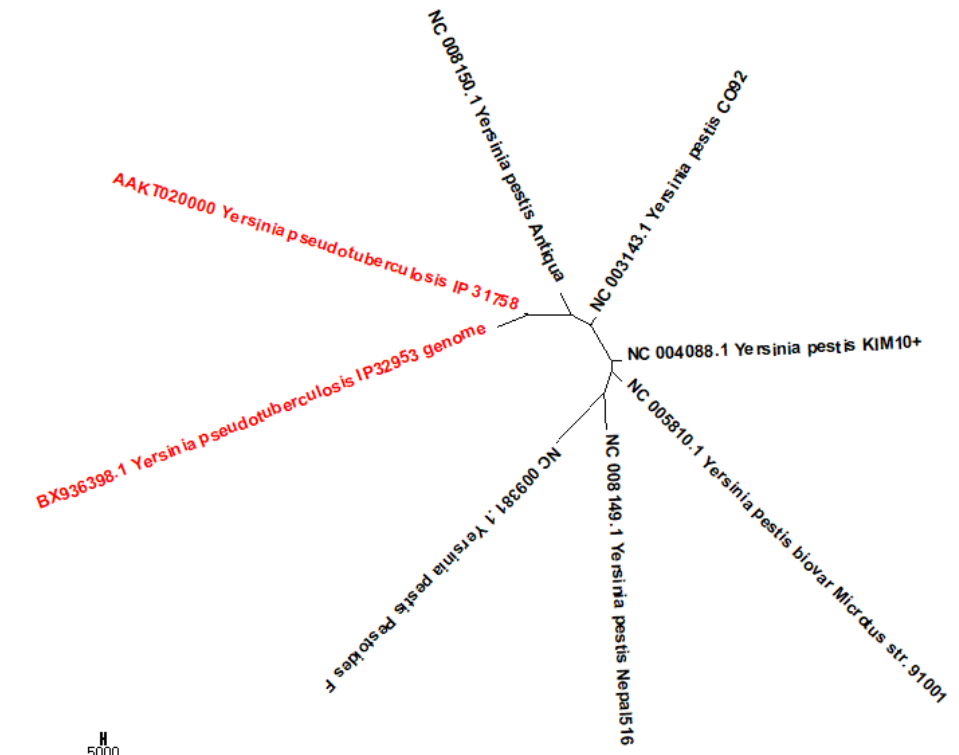
Figure 6. The Neighbor-Joining phylogenetic tree of eight Yersinia genomes based on PCNV